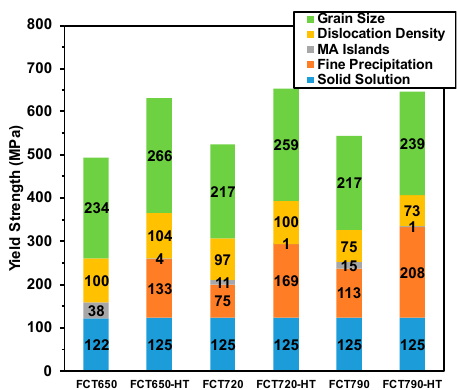
Figure 16. Individual strengthening contributions (grain size, dislocations, MA islands, precipitation and composition) for every microstructure (ferrite, ferrite/bainite and bainite, for FCT790, FCT720 and FCT650, respectively) and the samples obtained before (FCT) and after (FCT-HT) induction heat treatment.